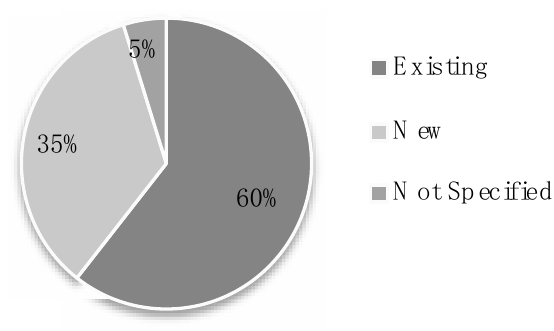
Figure 9. Reference buildings analyzed by building construction Figure 9 . Reference buildings analyzed by building construction type.